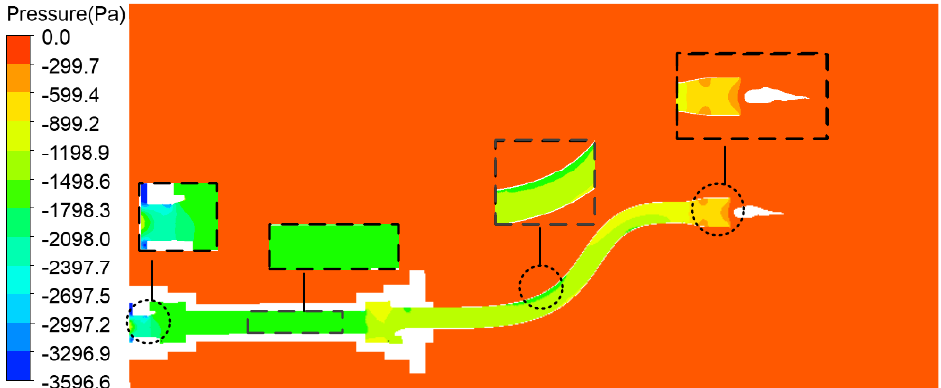
Figure 8. Flow field pressure distribution of HSMPS.